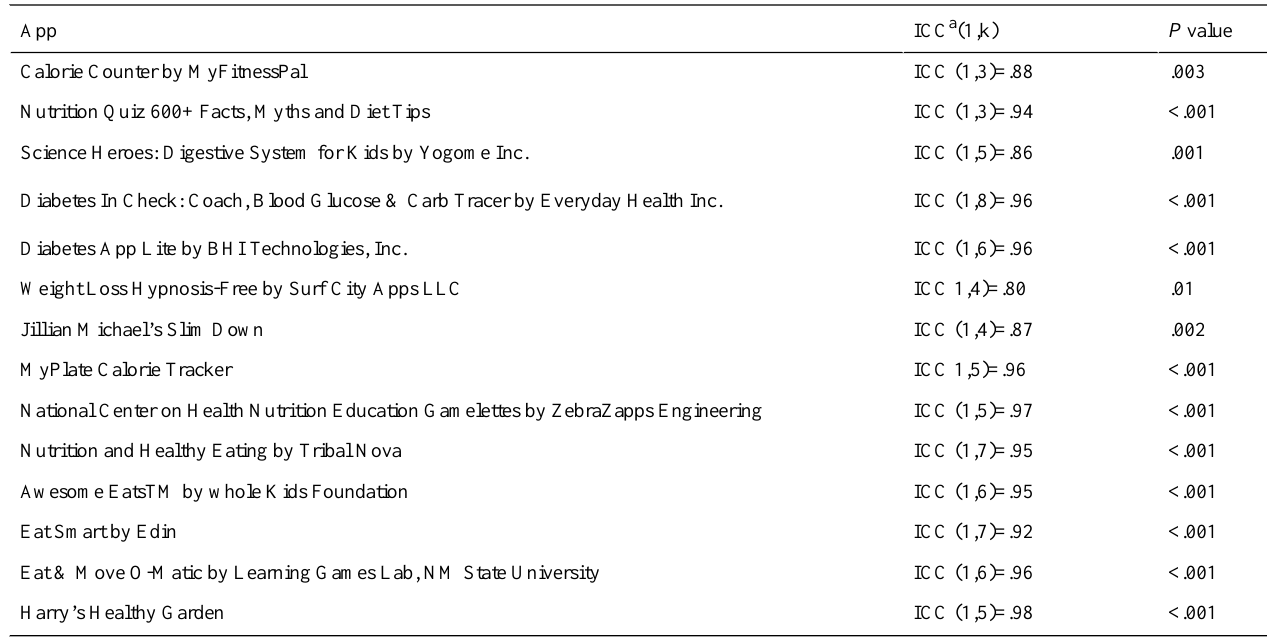
Table 4. Interrater reliability of dietitians evaluating apps using the app quality evaluation (AQEL) tool (n=75